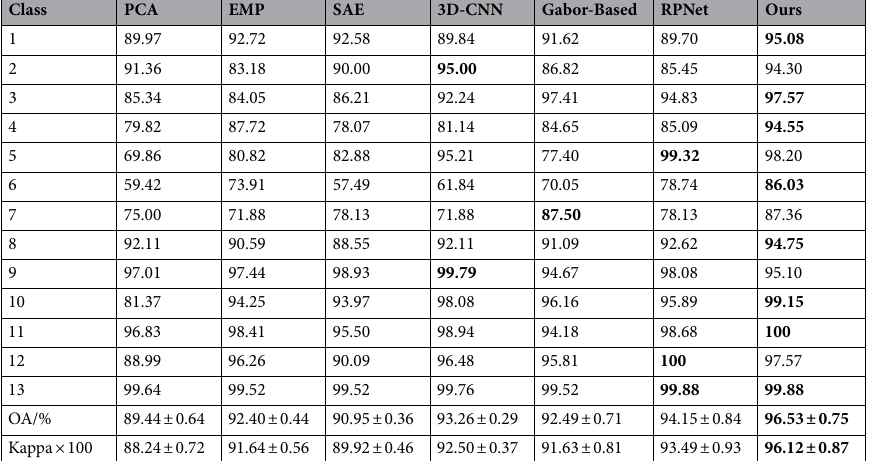
Table 6. Classification accuracy of Kennedy Space Center Dataset.